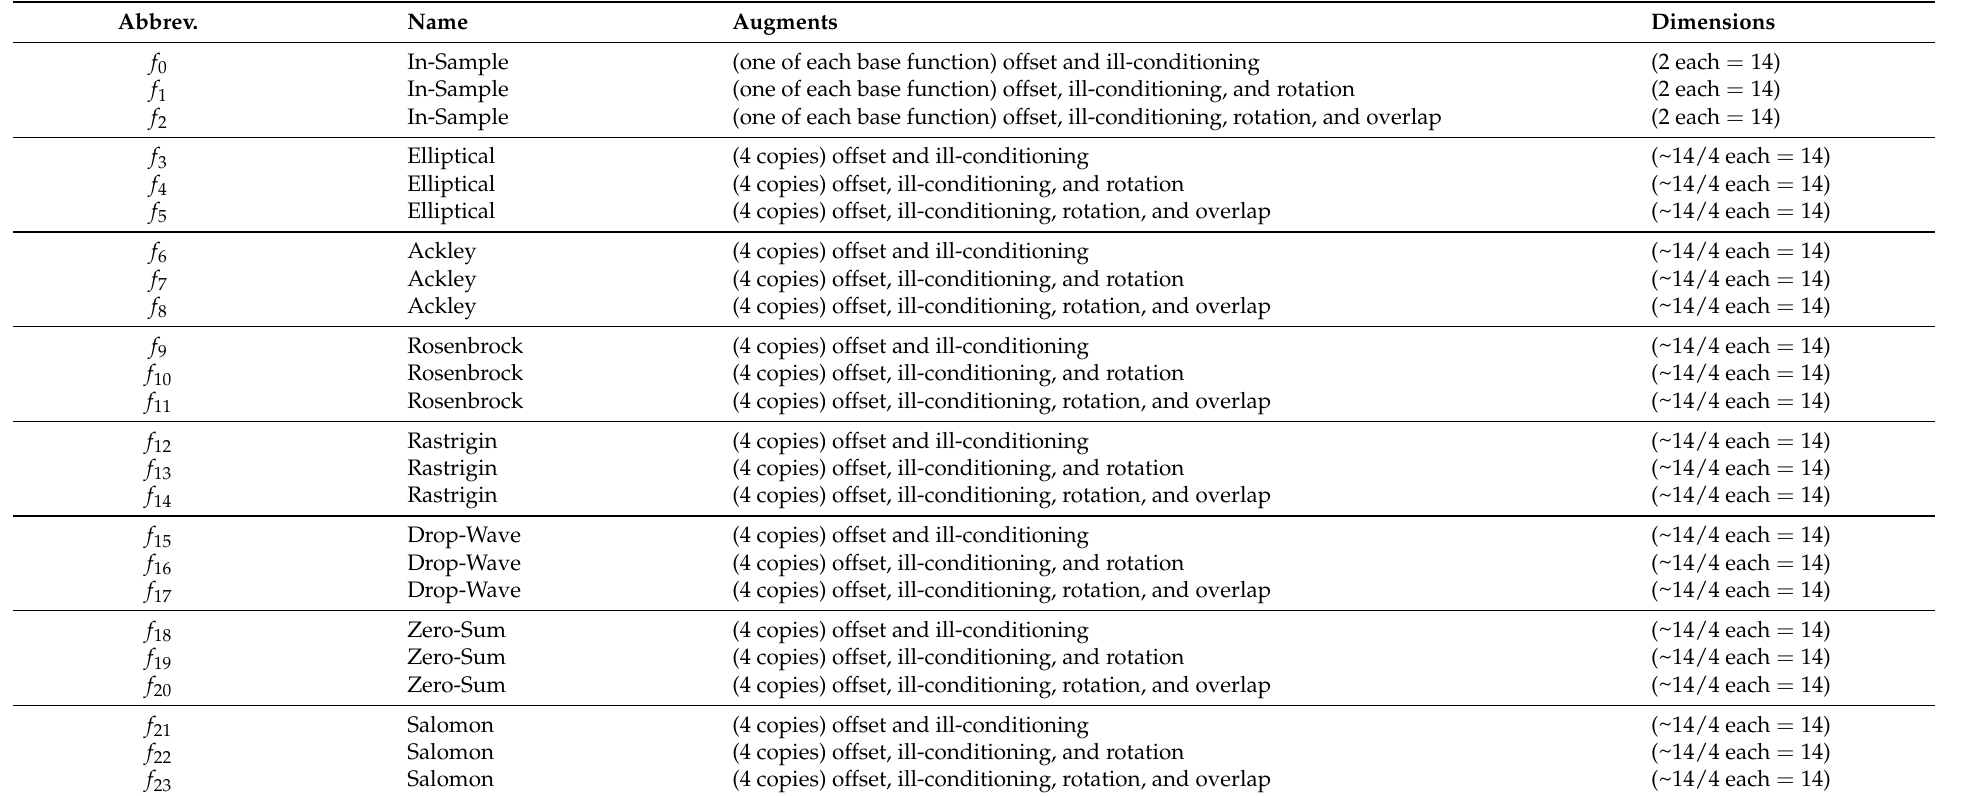
Table 1. The list of functions evaluated on for each